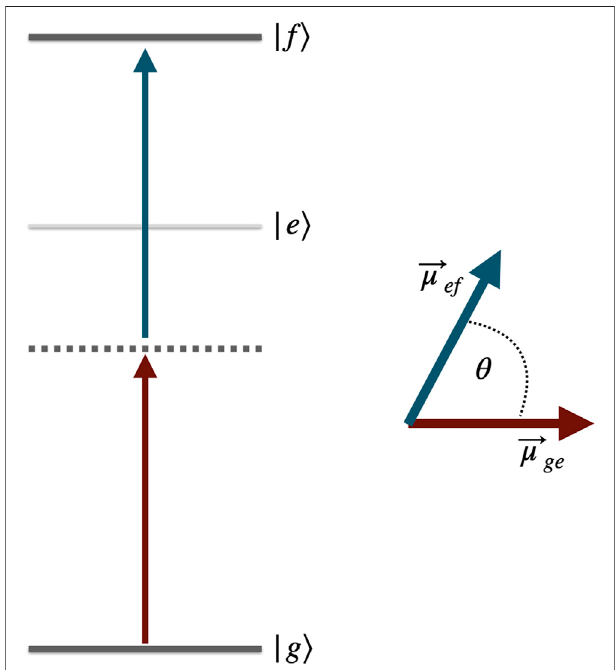
FIGURE 1 | Level scheme and dipole orientation considered in this paper: We consider two-photon excitation from the ground state | g 〉 to the fi nal state | f 〉 . The intermediate state | e 〉 is far-off-resonant from the carrier frequencies of the two photons. The dipoles between ground and intermediate state, (cid:2) μ ge , and between intermediate and fi nal state, (cid:2) μ ef , form a relative angle θ .